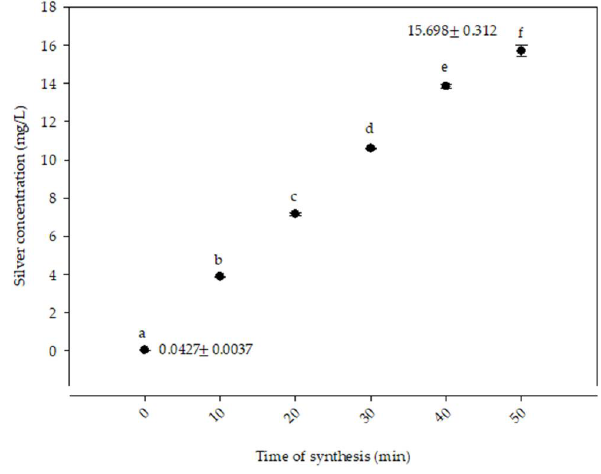
Figure 3. Silver ion concentration with respect to the synthesis time of AgNPs. Different letters show statistically significant differences ( p ≤ 0.05) between treatments.